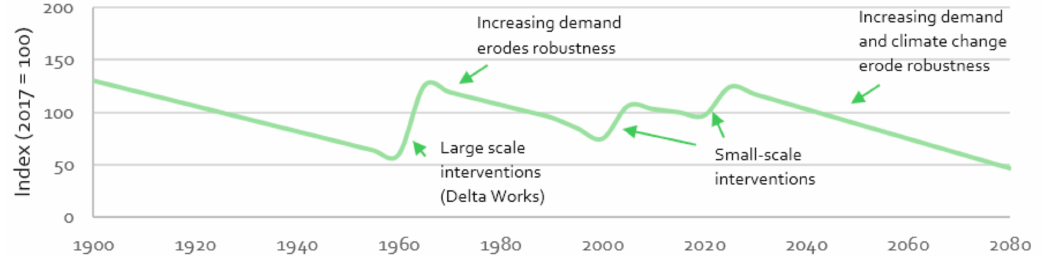
Figure 9. Representative mapping and narrative of robustness as a function of supply and demand, with interventions increasing robustness and increasing demand and climate change as slow variables. Small scale interventions can be minor canals or pumping stations. Source: